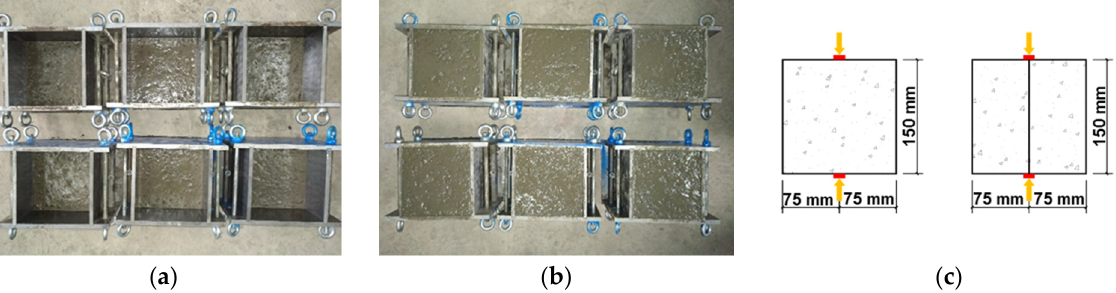
Figure 3. Concrete splitting tensile test: ( a ) Pouring lower layer concrete. ( b ) Pouring upper layer concrete. ( c ) Schematic diagram of splitting tensile test.